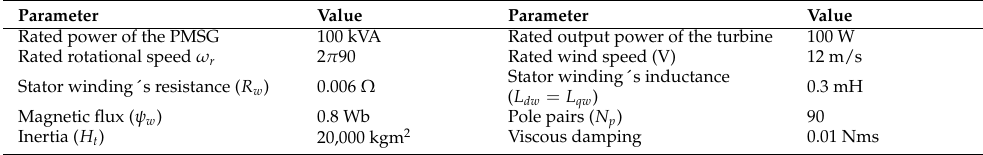
Table 3. Parameters of the